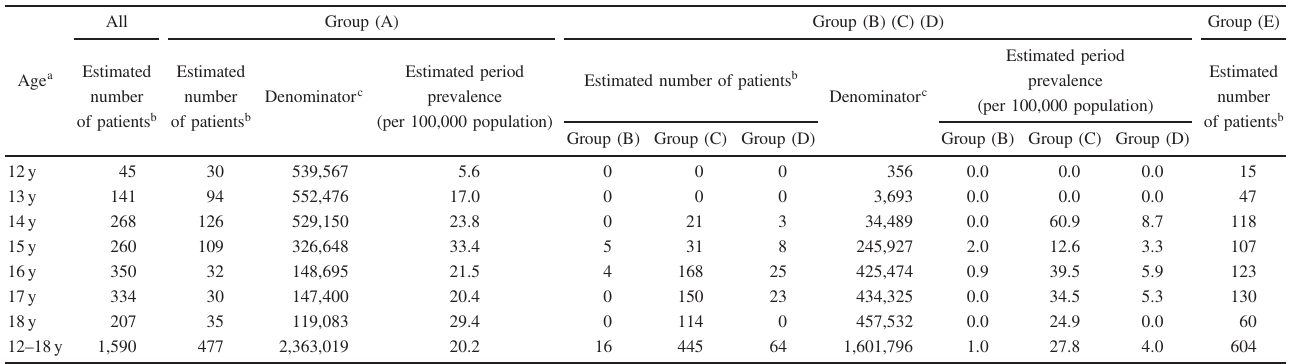
Table 5. Estimated period prevalence (per 100,000 population) during the period of July to December 2015 among girls with diverse symptoms, according to HPV vaccination status